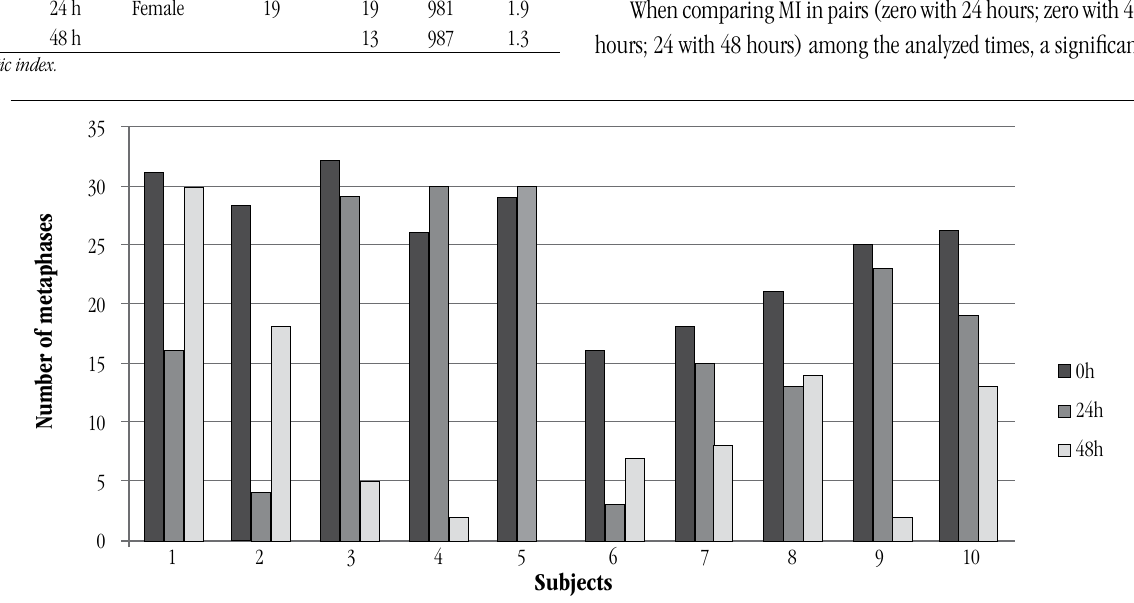
figurE 1 – Numbers of metaphases in cultures, by subject, at times zero, 24, and 48